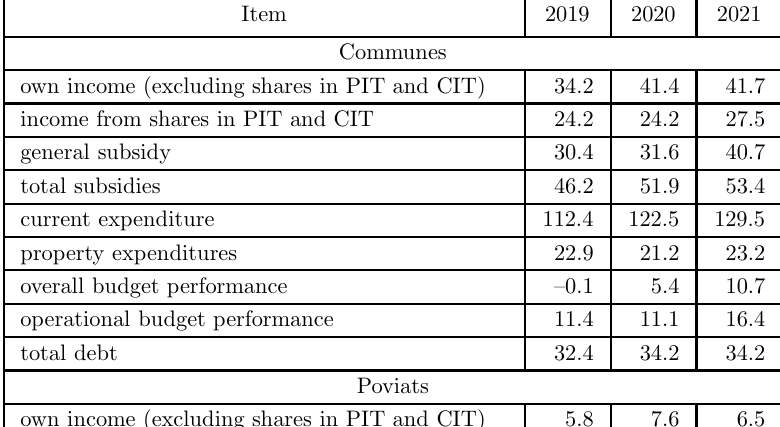
Selected categories of LCU budgets in Poland (2019–2021; PLN